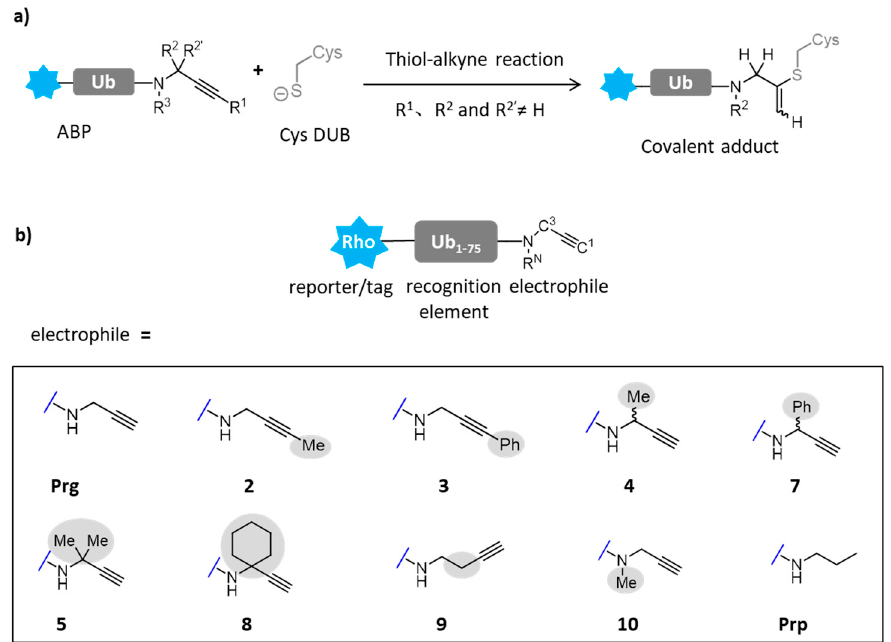
Figure 9. ( a ) Mechanism of activity-based probe targeting cysteine DUBs via thiol alkynyl click reaction. ( b ) A group of substituted alkynes in active probes (ABPs) targeting cysteine DUBs. Synthetic ubiquitin lacking glycine residues at the C-terminal (Ub 1 − 75 ) was modified with fluorescent rhodamine group at the N-terminal as reporter, and propargylamide (Prg) or propargylamide derivative 2–10 at the C-terminal as cysteine thiol-reactive electrophilic. Propylamide (Prp) was a non-covalent control.